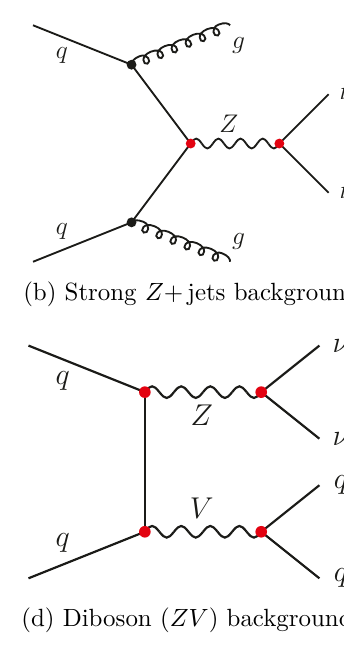
Representative Feynman diagrams for (a) the signal and for the three dominant background processes: (b) strong Z + jets, (c) electroweak Z + jets, and (d) diboson production. The latter two processes are collectively referred to as ‘electroweak’ Z production. Electroweak vertices are shown as red markers. For simplicity, no distinction is made between particles and antiparticles, or between different quark